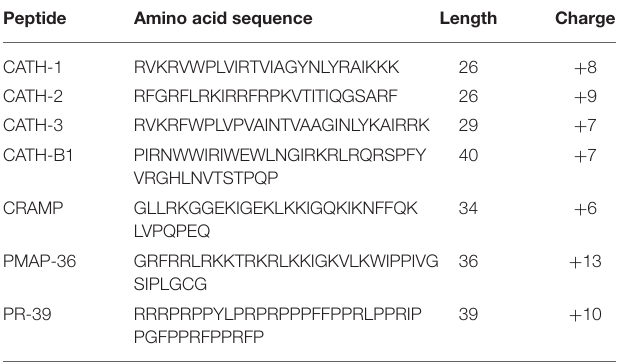
TABLE 1 | Characteristics of the peptides used in this study. Peptide Amino acid sequence Length Charge